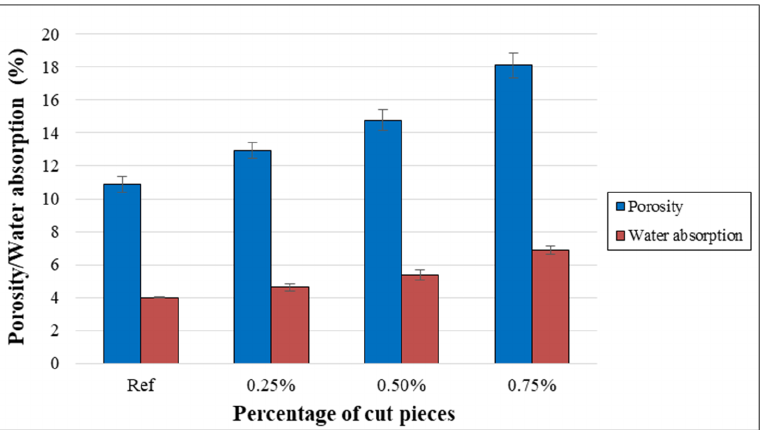
Figure 17. Relationship between porosity/water absorption and volume fraction of non ‐ woven tis ‐ sue .